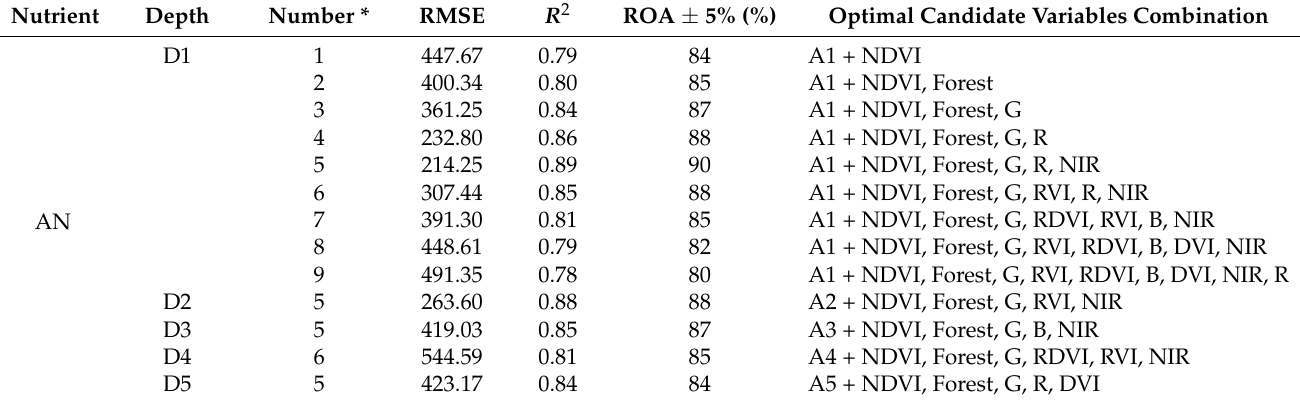
Table 3. Optimal variable combination and accuracies of full variables ANN model (Model B) of soil nutrients.